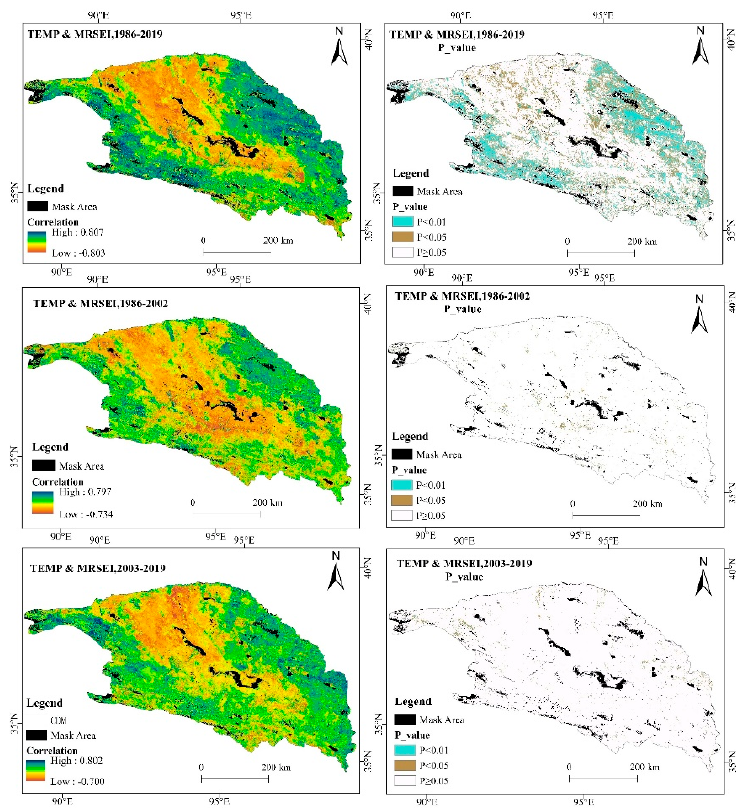
Figure 10. The correlation between MRSEI and precipitation from 1986 to 2019.